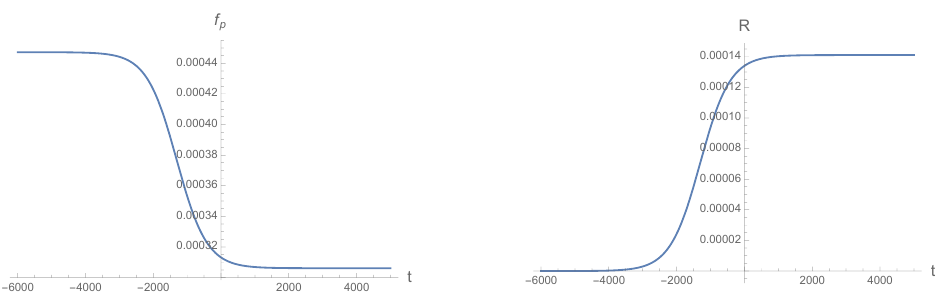
(cid:15) = 0 . 1 : in the UV limit ( t → ∞ ) the couplings flow to a point e